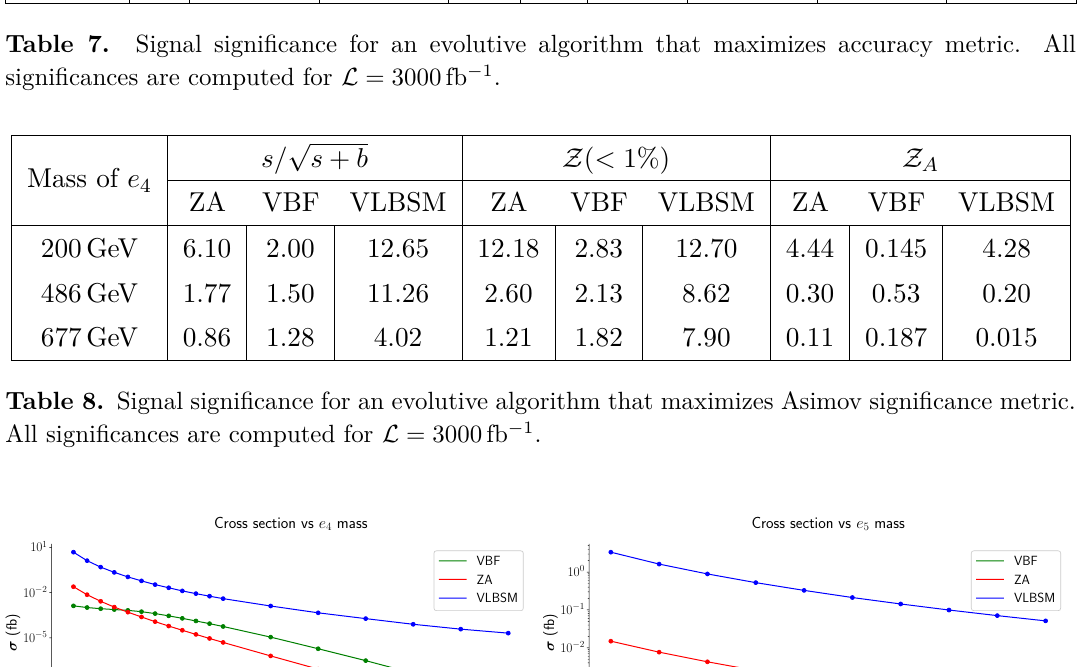
= 3 . 2 TeV , on the right one we have m 5